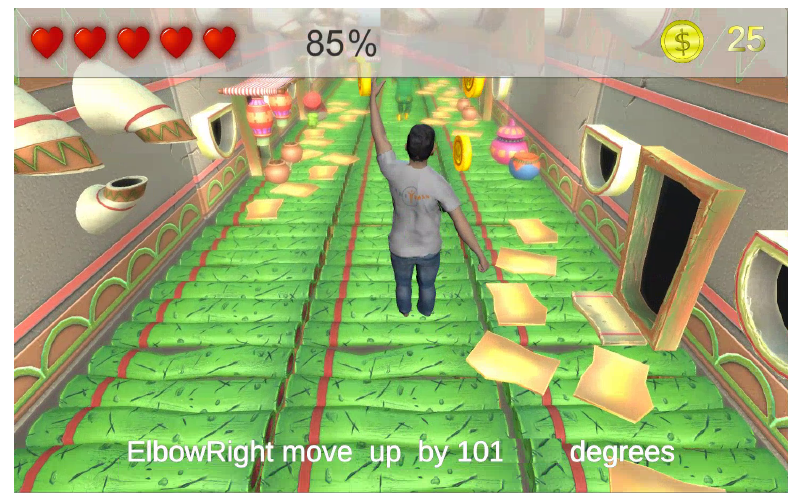
Figure 8. Alert is triggered with information on the gesture accuracy and instructions on how to